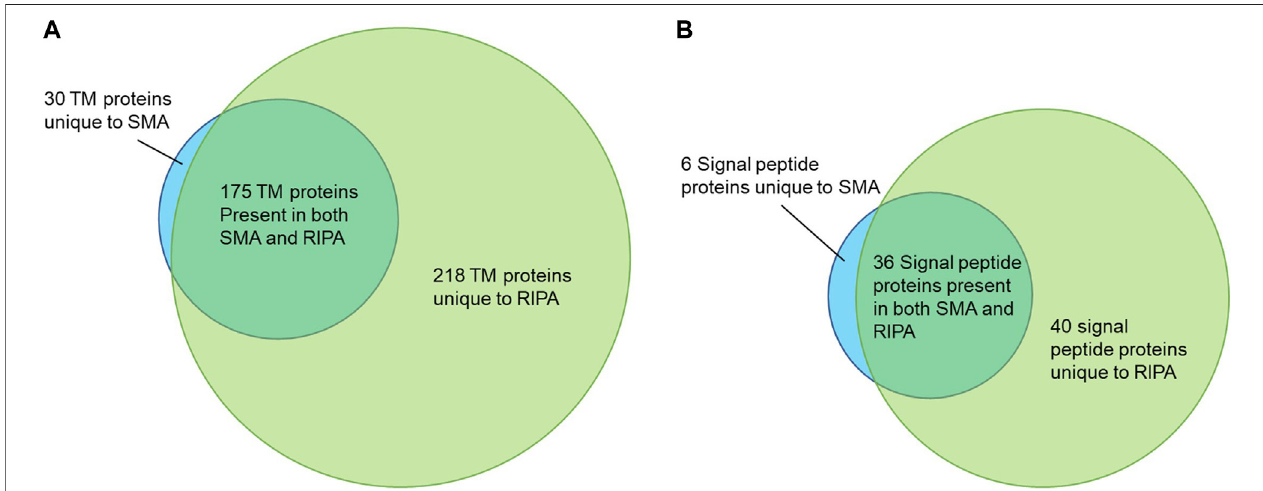
FIGURE 7 | (A) Venn diagram showing the transmembrane (TM) proteins identi fi ed following pull-756 down from SMA and RIPA extracts. (B) Venn diagram showing the signal peptide containing 757 proteins without TM domains identi fi ed following pull-down from SMA and RIPA